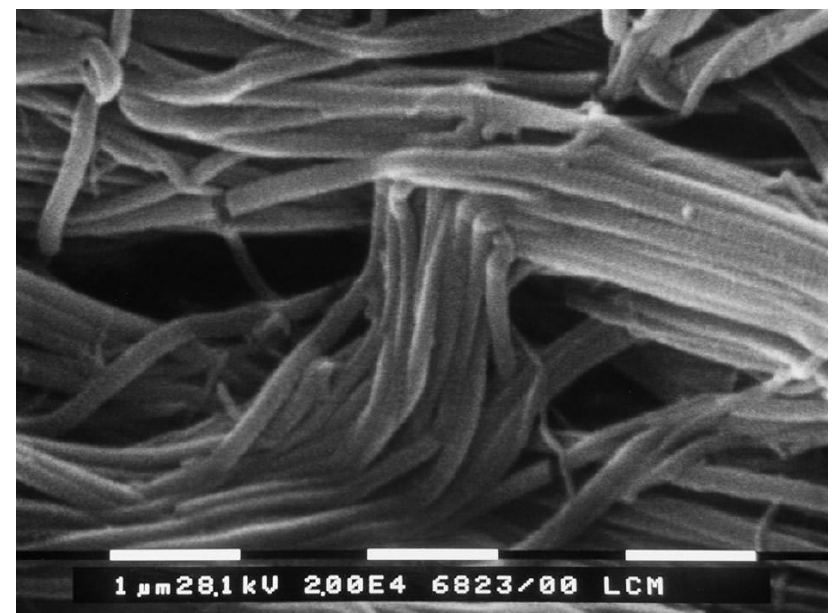
FIGURE 3. Rat medial collateral ligament incubated in ChAB observed at SEM. At higher magnification in the fibrillar crimp region, fibrils show a cross-connection to each other. Each fibril forming a knot or fibrillar crimp clearly first twists to the left (about 180°), thus changing the plane of direction, and then sharply bends, modifying the direction of its course. Bar = 1 µm.